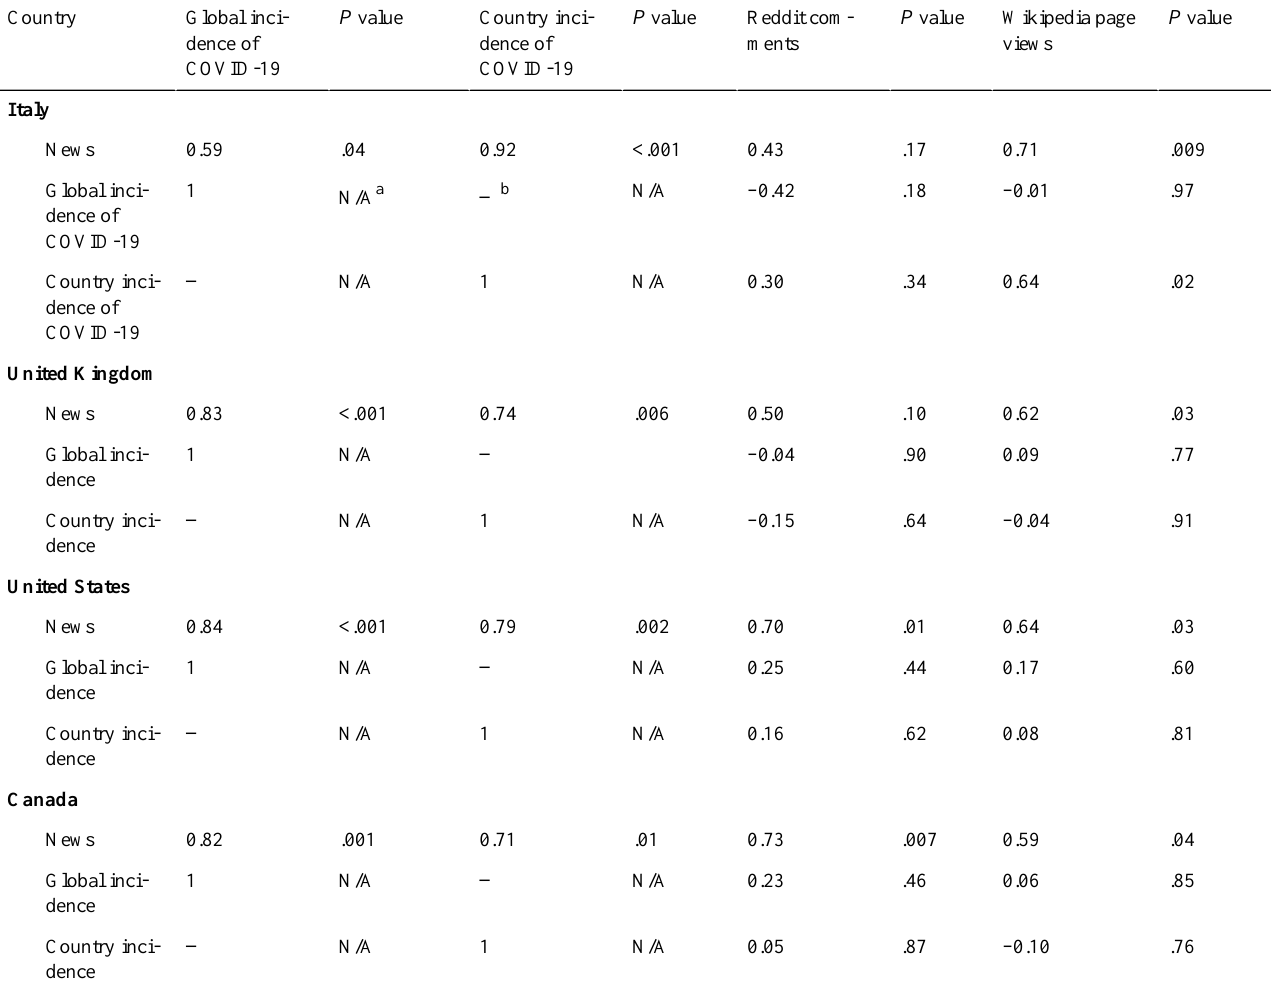
Table 1. Country-specific Pearson correlation coefficients for news coverage and global and domestic COVID-19 incidence, volumes of Reddit comments, and volumes of Wikipedia page views; domestic COVID-19 incidence and volumes of Reddit comments and Wikipedia views; and global COVID-19 incidence and volumes of Reddit comments and Wikipedia